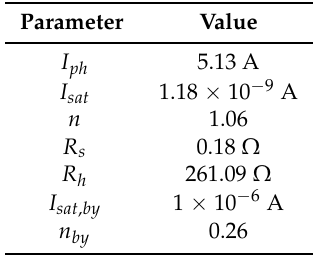
Table 3. Parameters for the simulations tests.